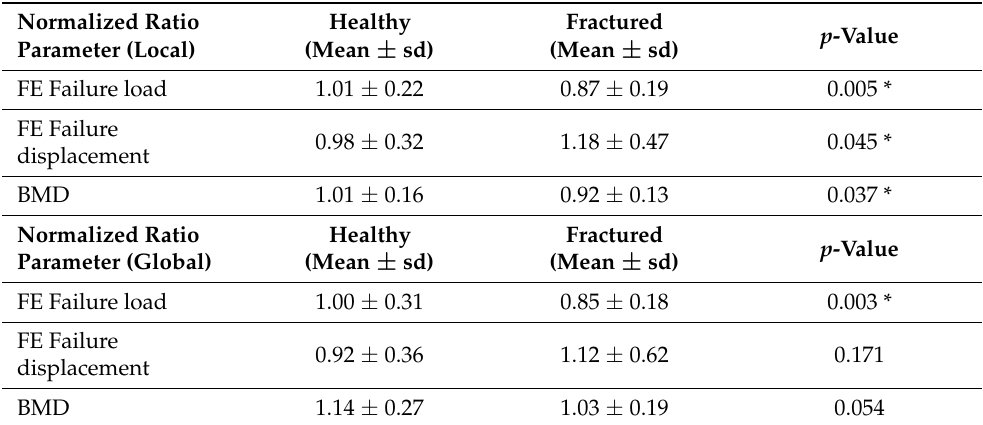
Table 3. Mean and standard deviation (sd) of bone mineral density (BMD) and finite element (FE)-based failure load and displacement normalized ratios for healthy and incidental fractured vertebrae.